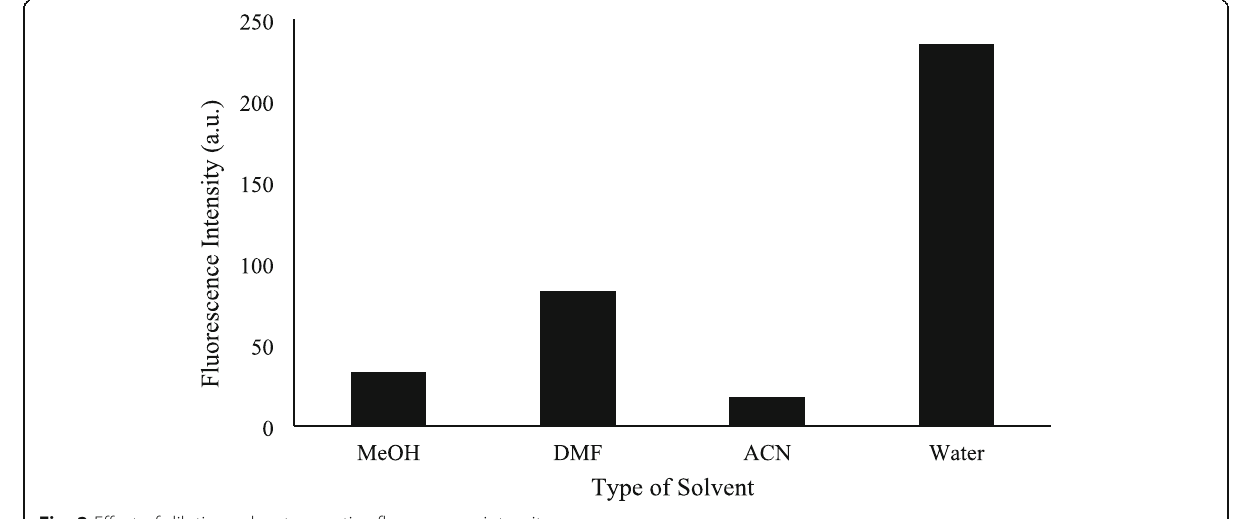
Fig. 2 Effect of diluting solvent on native fluorescence